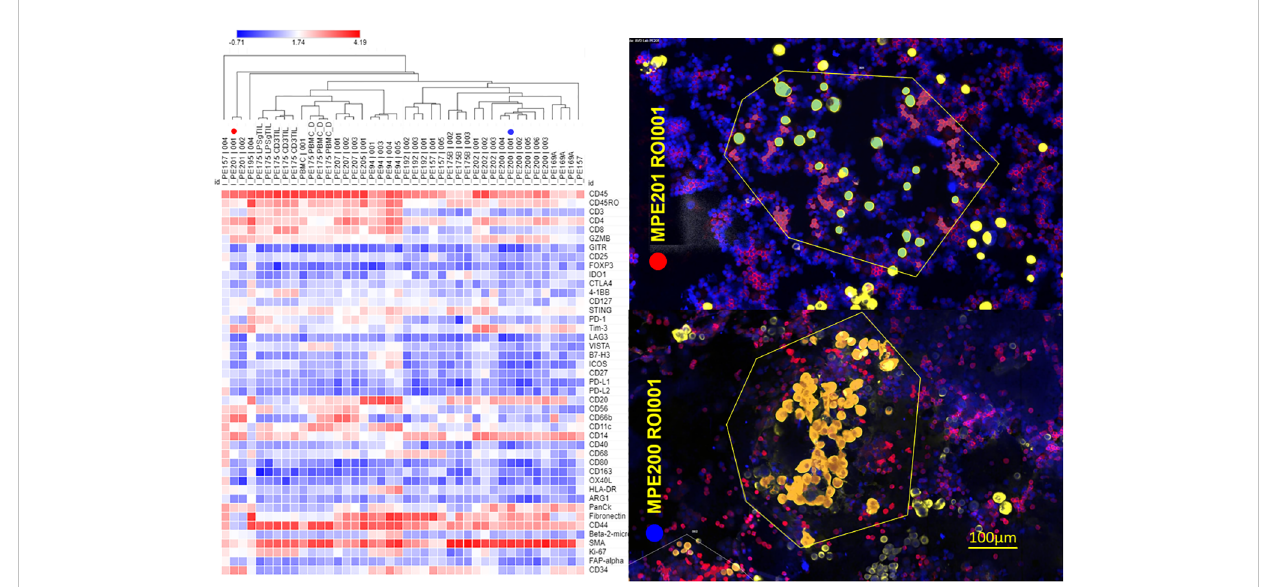
FIGURE 3 Proteomic pro fi ling of CD45+ MPE cells. NanoString GeoMx digital spatial pro fi ling was performed on 12 breast cancer MPE cytocentrifuge preparations, 2 peripheral blood mononuclear cell preparations (PBMC), and one activated PIT. Left panel: Regions of interest (ROI) were segmented on CD45 positivity determined by immuno fl uorescence. Log-transformed normalized data are displayed as a heatmap with hierarchical clustering of the samples/ROI. Sample identi fi cation number and ROI appear above each column; CD3 TIL = CD3/CD28/IL-2 activated, LPSg = LPS/IFN g activated, PBMC = freshly isolated peripheral blood mononuclear cells. PE201 (ROI 1, red circle) and PE200 (ROI 1, blue circle) represent T-cell-rich and macrophage-rich samples, respectively. Right panel: False-colored immuno fl uorescent photomicrographs (PE201/ROI 1, PE200 ROI 1) used for selecting ROI (enclosed in yellow polygons). Red = CD45+, Gold = pan-cytokeratin+, Blue DAPI+. Proteomic analysis was performed on CD45+ (red) segments within